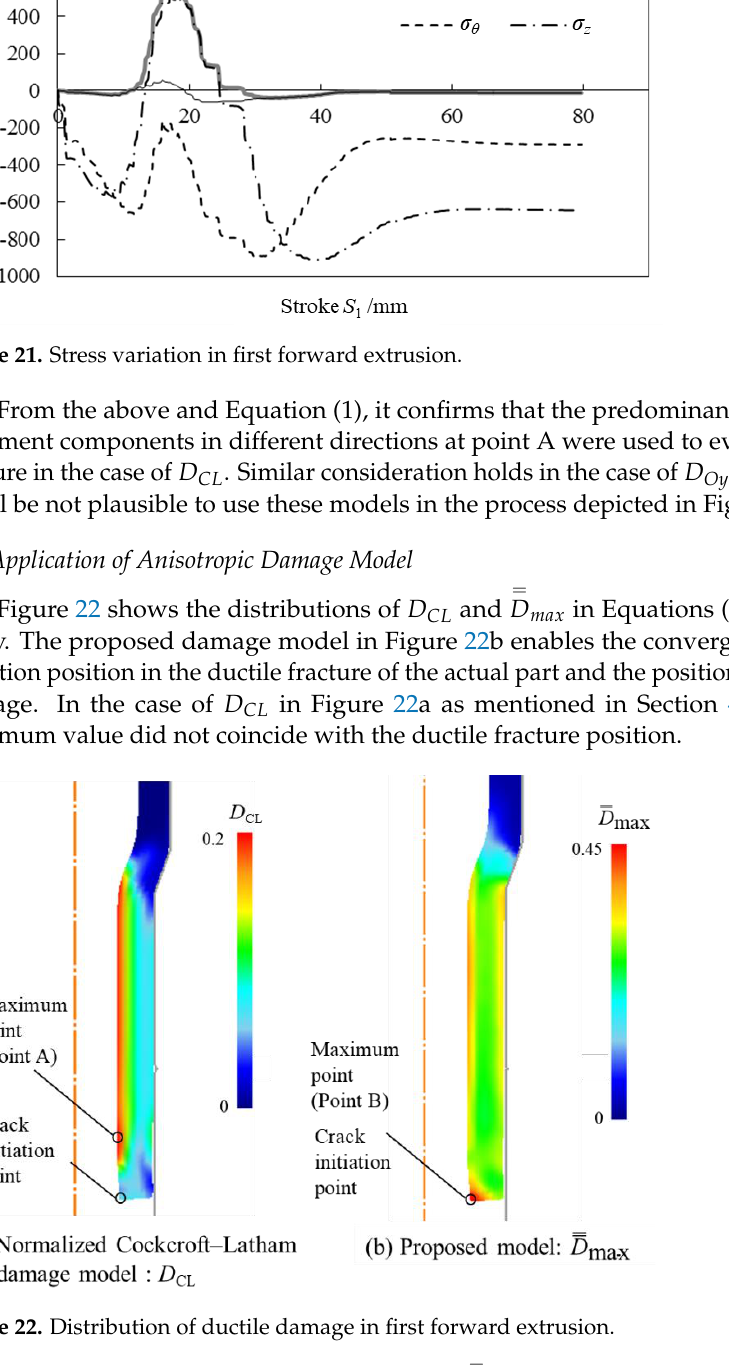
Figure 20. Strain variation in first forward extrusion.